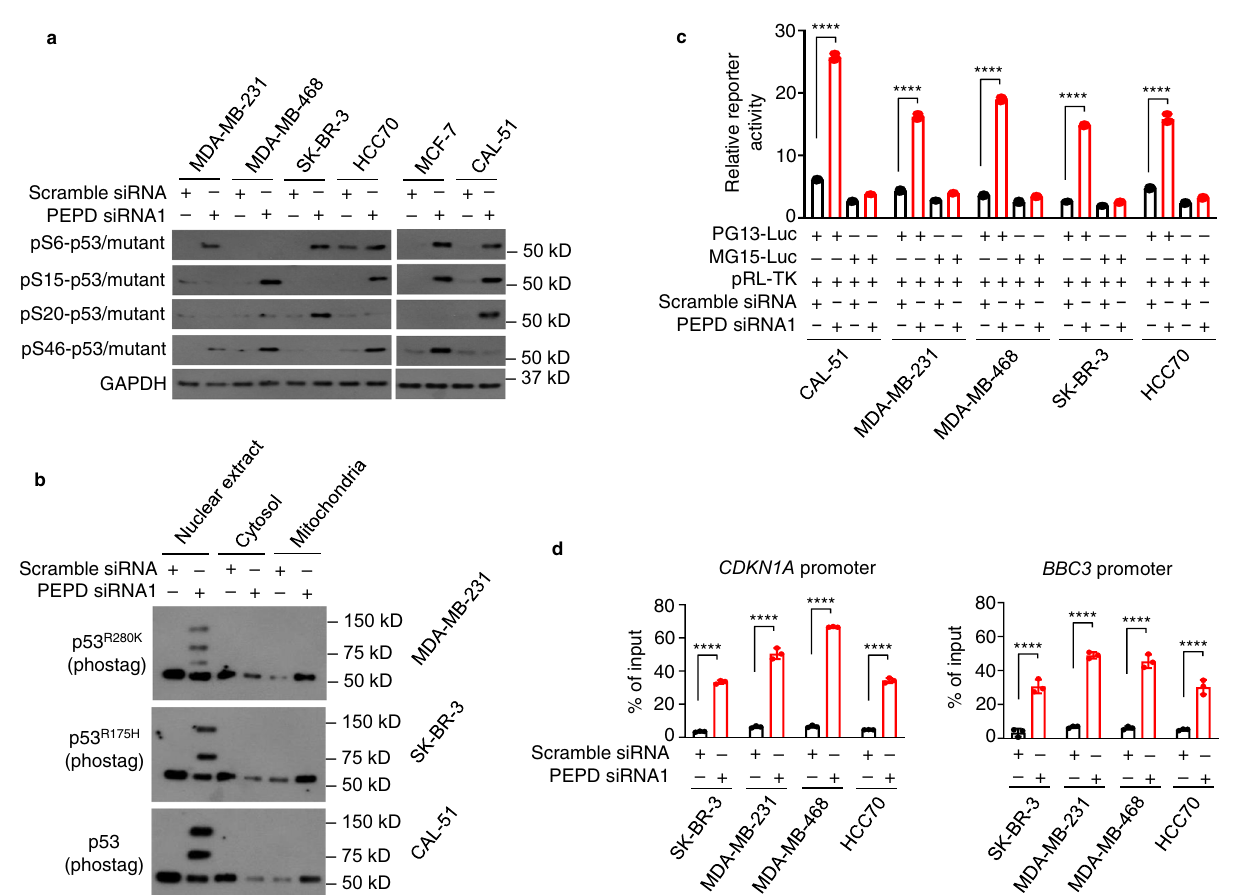
Fig. 6 PEPD KD reactivates the transcription-dependent tumor suppressor activities of p53 mutants. a Cells were treated by siRNA (10 nM) for 24 h. Phospho-p53 and phospho-p53 mutants in WCL were analyzed by WB. GAPDH is a loading control. b Cells were treated by siRNA (10 nM) for 48 h. Phospho-p53 and phospho-p53 mutants in subcellular fractions were analyzed by phostag WB. c Cells were transfected with an equal amount of PG13-Luc or MG15-Luc along with pRL-TK and 24 h later treated with siRNA (10 nM) for 48 h. Luciferase activity was measured in WCL. d Cells were treated by siRNA (10 nM) for 48 h. Binding of p53 mutants to the p53-binding sites in the promoters of CDKN1A and BBC3 genes were measured by ChIP-qPCR assay. The bar-dot plots in c and d show individual values and mean ± SD ( n = 3). **** P < 0.0001, by paired two-tailed t -test. Cells carrying p53 (MCF-7 cells and CAL-51 cells) or MDA-MB-231 (p53 KO ) cells were included in a – c for